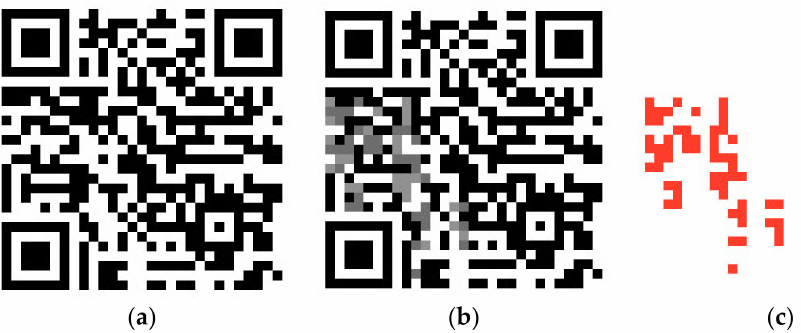
Figure 12. Example of SmartTag with irreversible thermochromic sensors used in the evaluation: ( a ) Reference QR code before changing state; ( b ) QR after sensor change state and marked difference between data matrixes (grey); ( c ) functional ink for printing used as a mask over reference QR code.